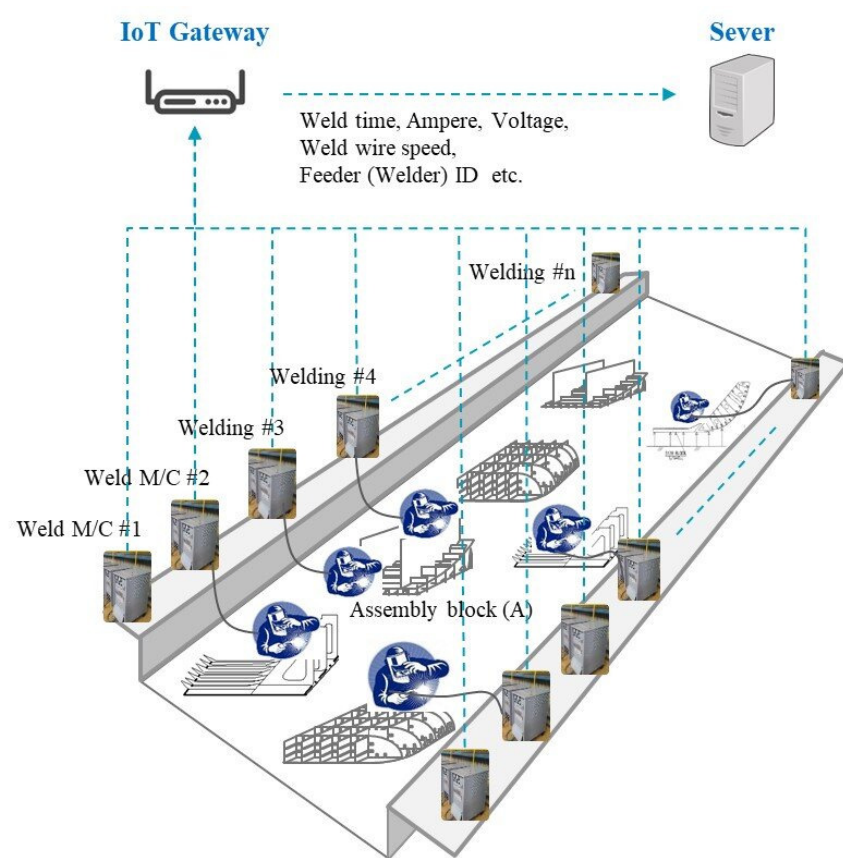
Figure 12. Configuration diagram of the welding data acquisition